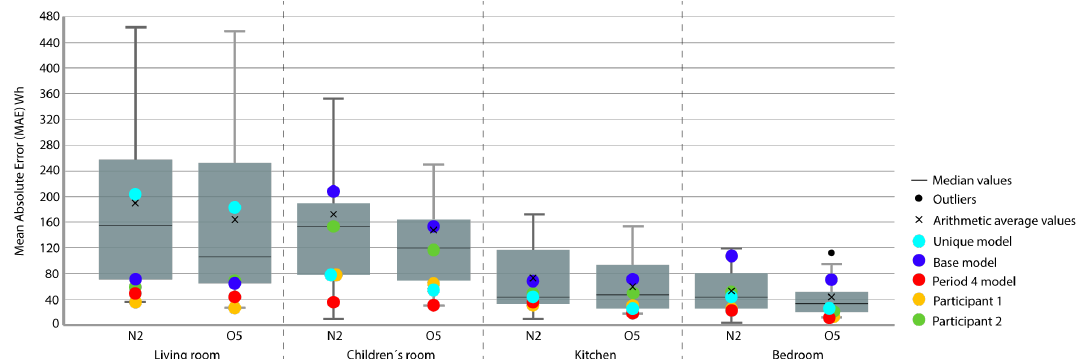
Figure 10. Energy MAE for Period 4 (fixed set point at 25 ◦ C).